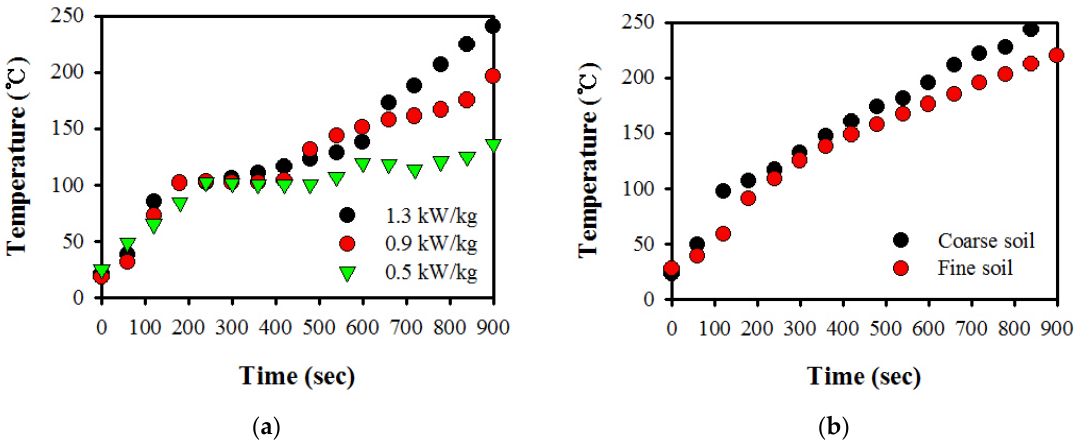
Figure 2. Temperature profiles of soil for ( a ) microwave power density and ( b ) different particle sizes with time during microwave irradiation.